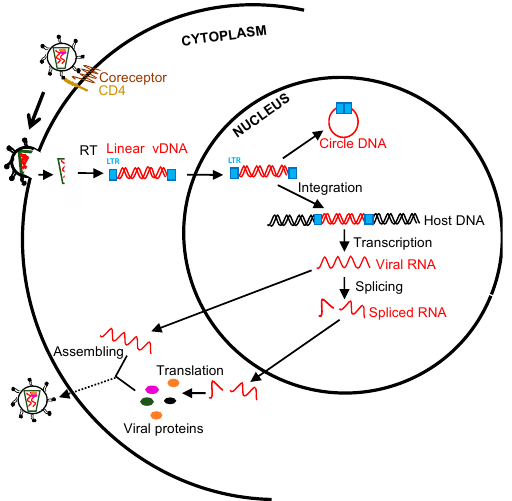
Figure 1. Schematic overview of human immunodeficiency virus (HIV)/ simian immunodeficiency virus (SIV) life cycle and measurable viral parameters. Viral particles enter target cells, followed by reverse transcription, integration, transcription, splicing, translation, and virion packaging. The unspliced viral RNAs are transcribed from the integrated provirus. The transported single 5 (cid:48) capped genomic viral RNAs (~9 Kb) are assembled to the nascent virions. Two or three guanosines 5 (cid:48) full-length viral RNAs directly translate viral proteins (gag and pol). Rev-dependent export of incompletely spliced RNAs (~4 Kb) to cytoplasm contributes to env, vif, vpr, and vpu expression, whereas rev-independent multiply spliced species (~2 Kb) constitutively express accessory and regulatory proteins (tat, rev, and nef). Cell-associated viral RNA transcripts and viral DNA can be directly measured [18–20].